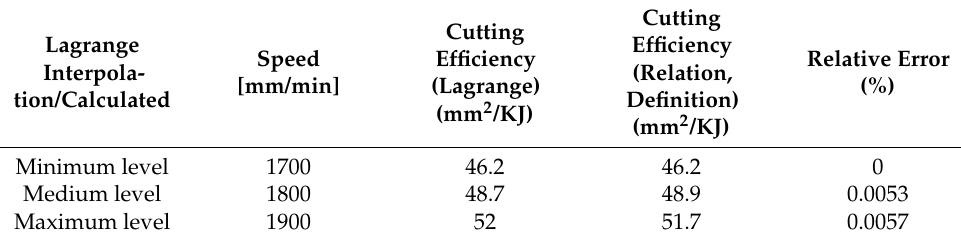
Table 8. Cutting efficiency obtained by different